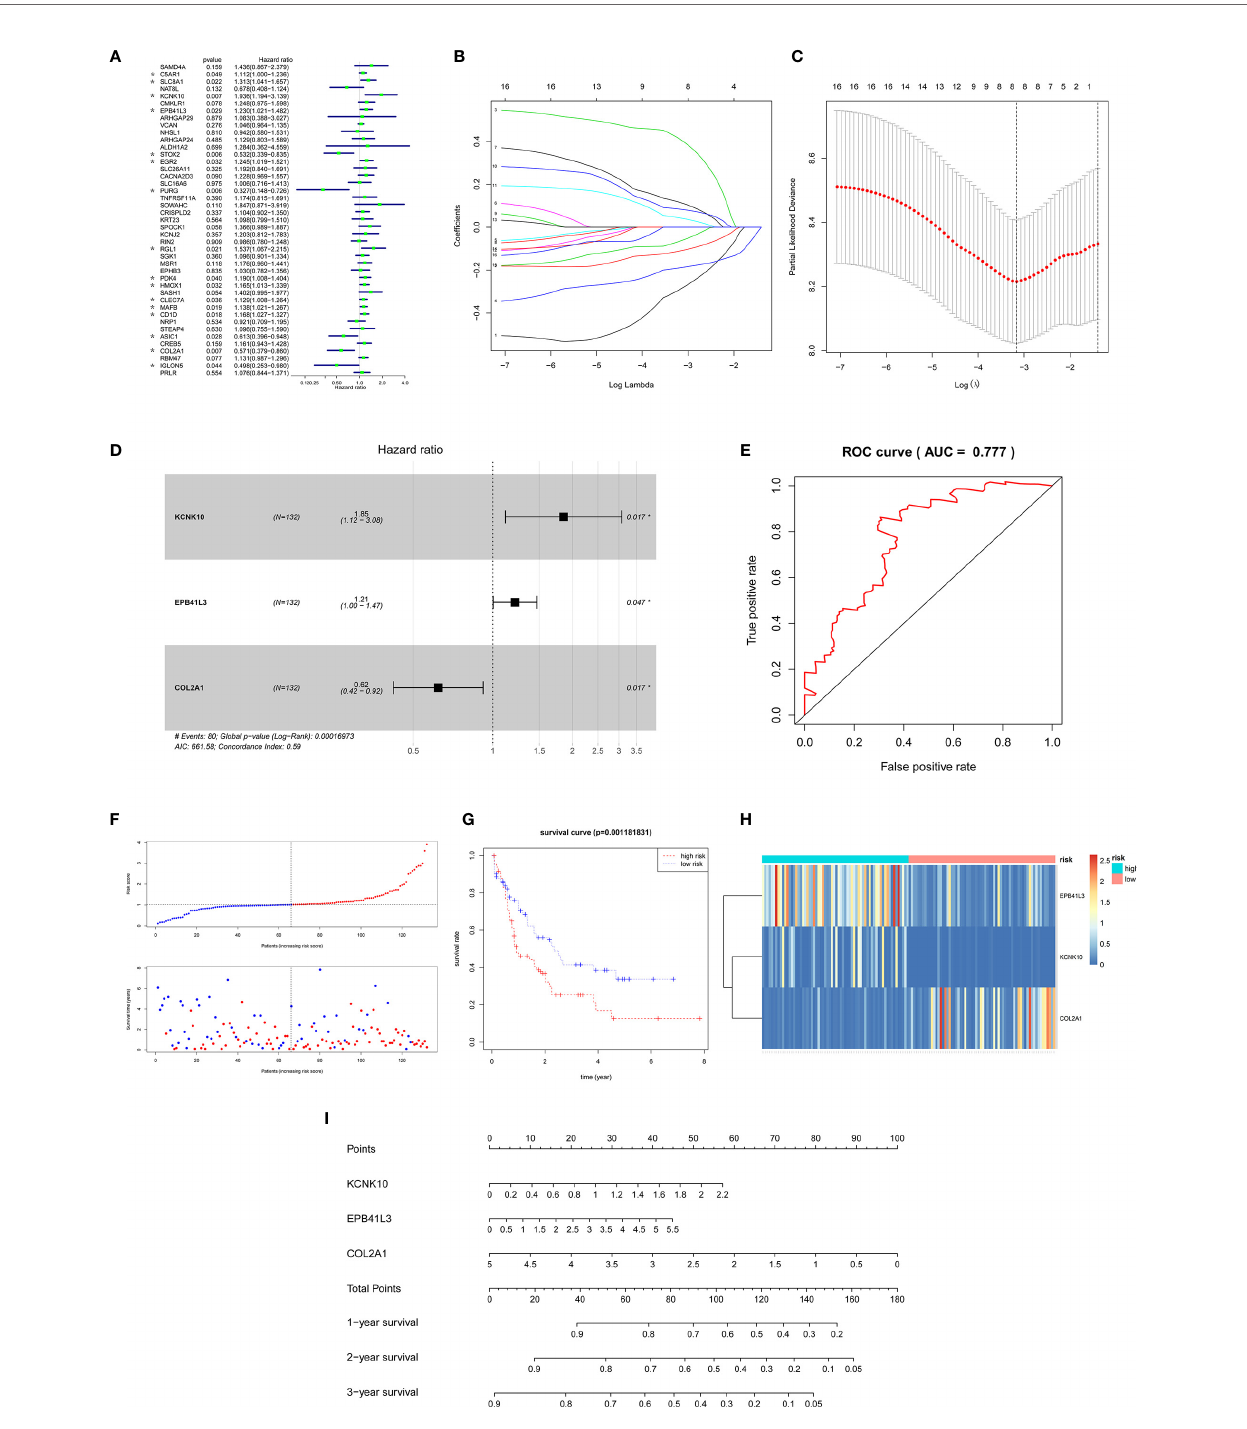
FIGURE 5 | Construction of the survival model to screen hub prognostic mRNAs. (A) Forest map of univariate Cox proportional hazards regression: 16 mRNAs with P < 0.05 were screened out of 43 common mRNAs (marked by *). (B, C) Lasso regression screening of mRNAs into multivariate Cox regression: l and cv graphs show that eight hub mRNAs were selected. (D) Forest map of multivariate Cox proportional hazards regression: three hub prognostic mRNAs (KCNK10, EPB41L3, COL2A1) were screened out. (E) ROC curve of multivariate Cox regression: AUC of 5-year survival was 0.777, indicating the high accuracy of multivariate Cox regression model. (F) The AML samples were divided into high and low risk groups according to the risk scores obtained from Cox regression. (G) Survival curve of high and low risk groups: the survival rate of the high-risk group was signi fi cantly reduced (P = 0.0011). (H) Heatmap of KCNK10, EPB41L3, and COL2A1 expressions among the high and low risk group samples. (I) Nomogram of KCNK10, EPB41L3, and COL2A1 based on the results of the multivariate Cox